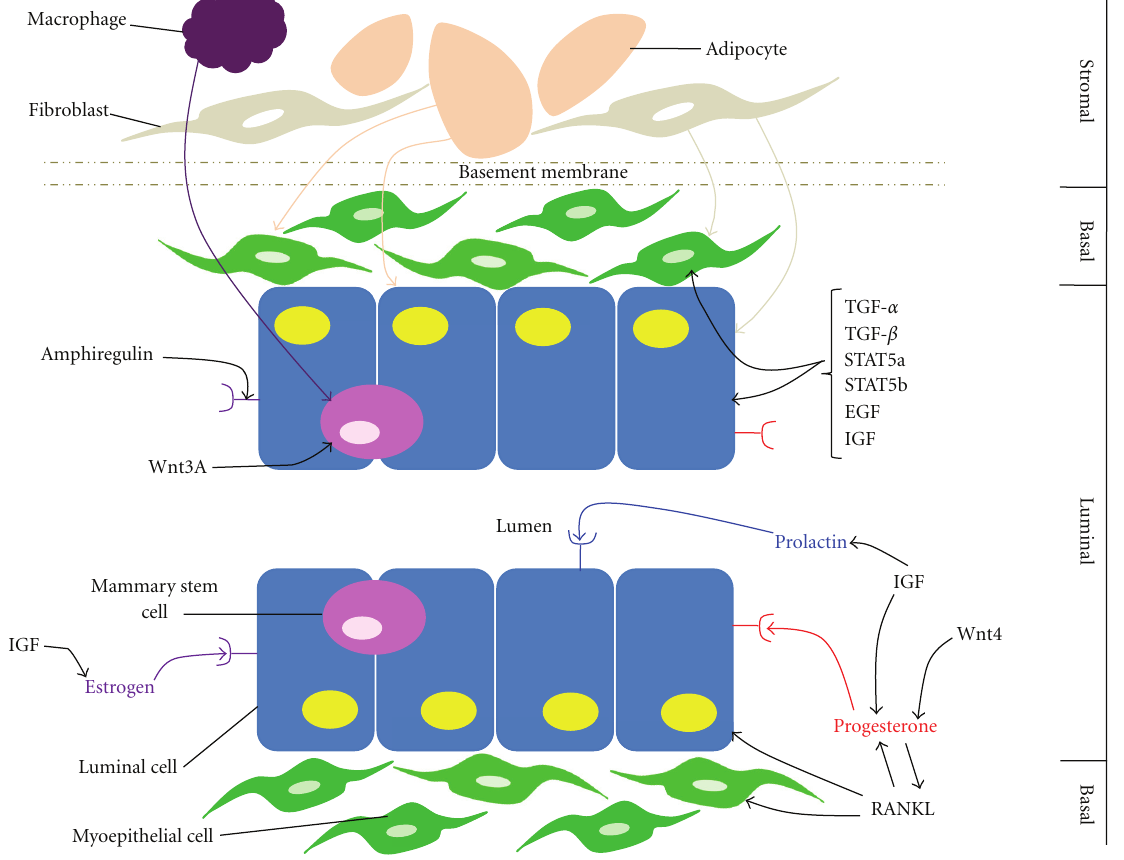
Figure 2: The mammary gland microenvironment. The major cell types of the mammary gland, luminal epithelial (luminal compartment) and myoepithelial cells (basal compartment), are separated from the stromal compartment by a basement membrane. Both the luminal epithelial and myoepithelial cell growths are mediated by adipocytes and fibroblasts located within the stroma, as well as by estrogen, progesterone, prolactin, TGF- α , TGF- β , STAT5a, STAT5b, EGF, IGF, and RANKL signaling. Wnt3A signaling regulates mammary stem cells present in the luminal compartment. IGF mediates the mammary gland’s response to estrogen, while RANKL, IGF, and Wnt4 mediate the response to progesterone. IGF additionally regulates prolactin signaling. Estrogen receptor expression is mediated by